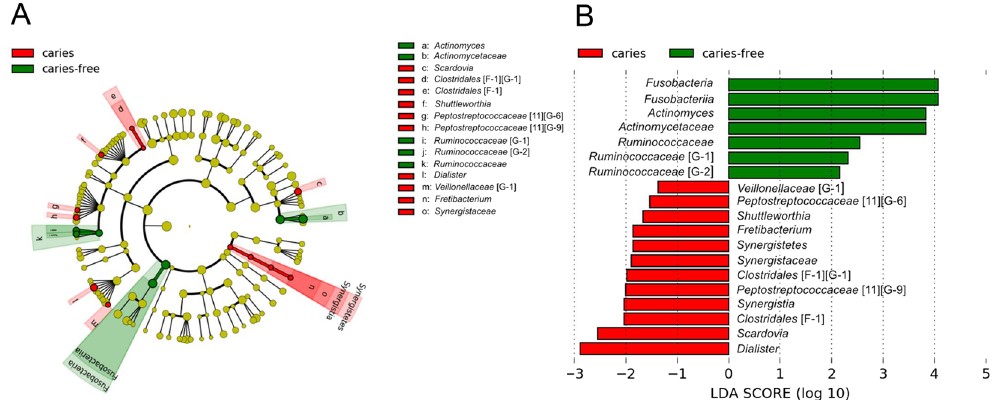
Figure 4. LEfSe analysis of saliva microbiota in caries versus caries-free adolescents. ( A ) Cladogram generated by LEfSe indicating differences at phylum, class, family and genus levels between the two groups. Each successive circle represents a phylogenetic level. Regions in red indicate taxa enriched in caries affected while regions in green indicate taxa enriched in caries-free subjects. Differing taxa are listed on the right side of the cladogram. ( B ) Bar graph showing LDA scores.